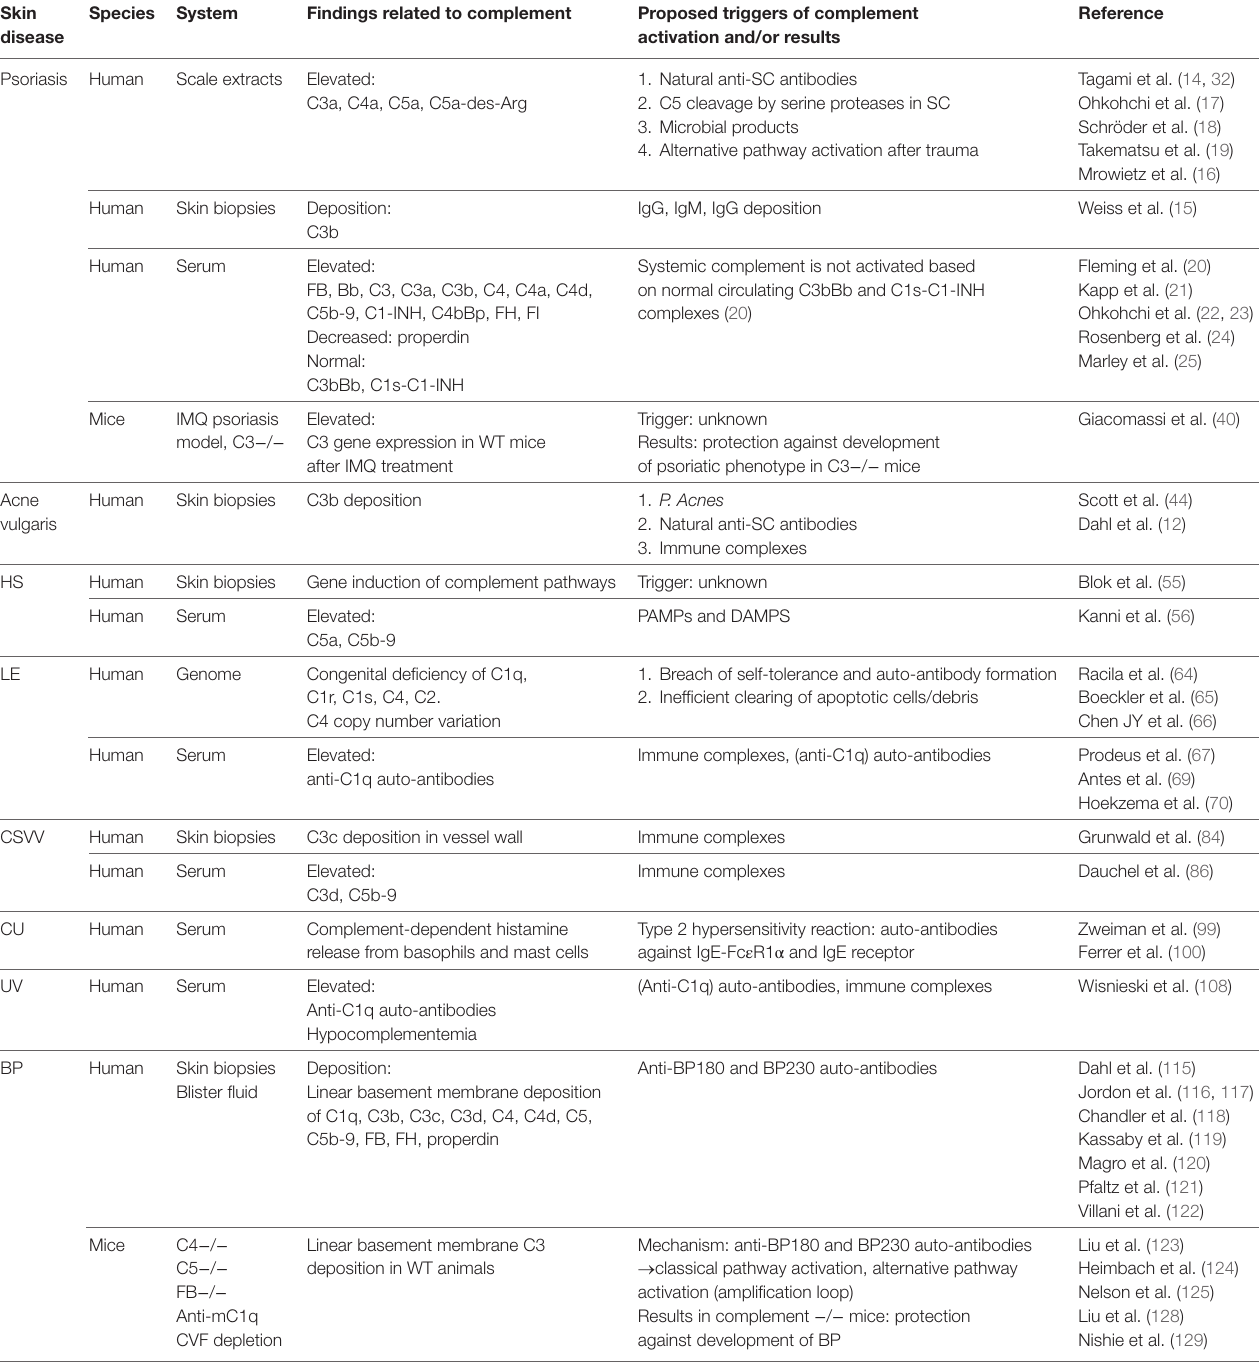
TABLe 1 | Overview of complement in skin diseases and the proposed triggers of complement activation. Skin Species disease